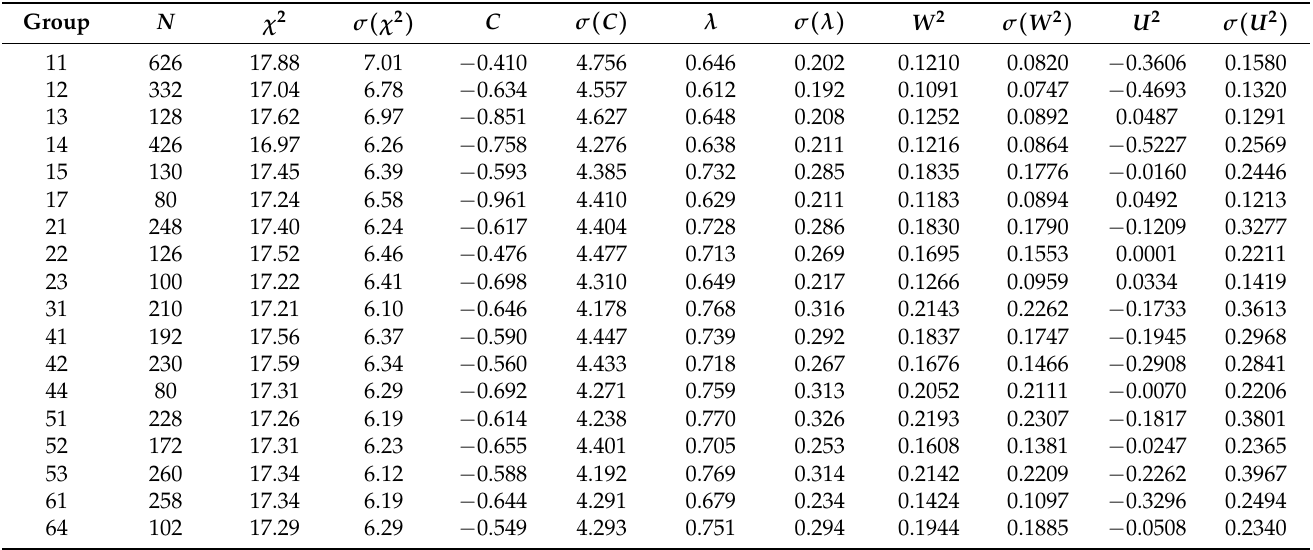
Table 7. Result of the numerical simulations—mean values of δ D angle statistical tests with standard deviations—part 1.